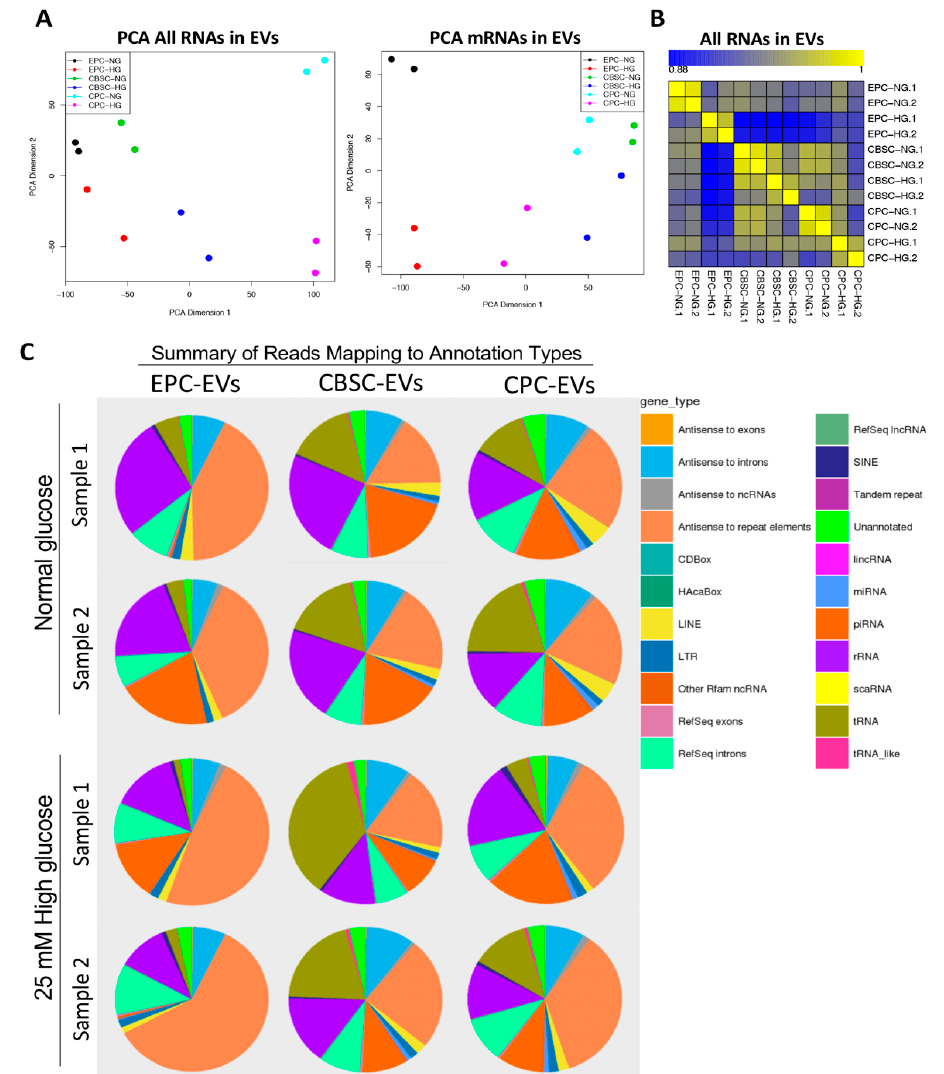
Figure 2. Whole transcriptome analysis of EPC-, CPC-, and CBSC-derived EVs and gene annotation types. ( A ) All EV RNA-seq data were processed using multi-dimensional scaling. Each dot represents a biological duplicate. ( B ) Pearson correlation of RNA-seq data. ( C ) Pie chart represents the fraction of each RNA type constitutes of total RNA content in EVs of EPC, CPC, and CBSC under NG and HG conditions.